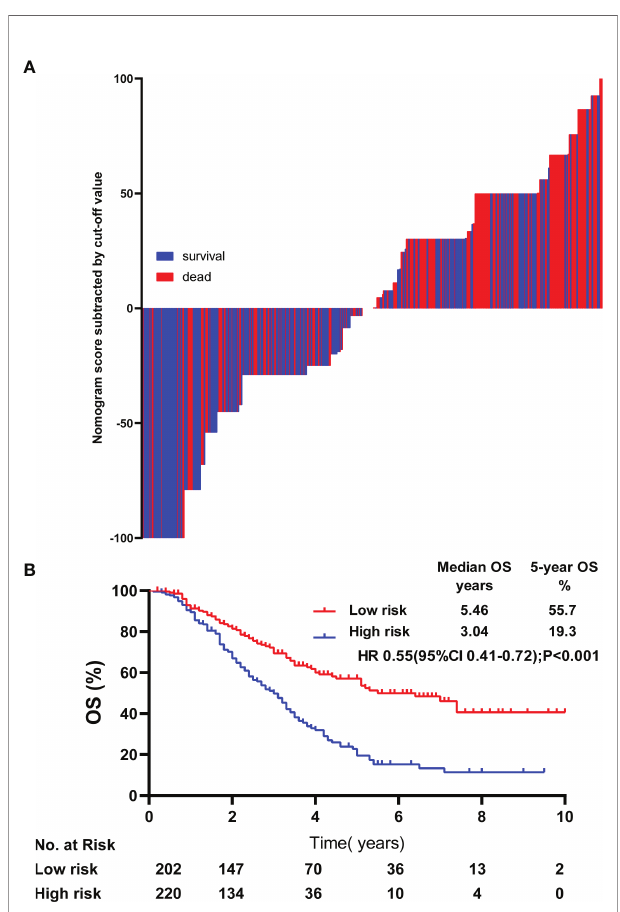
FIGURE 4 | Risk strati fi cation of lrNPC patients. The calculated risk scores for each patient in the whole cohort (A) . Kaplan-Meier survival curves of OS in the whole cohort (B) OS, over survival; HR, Hazard